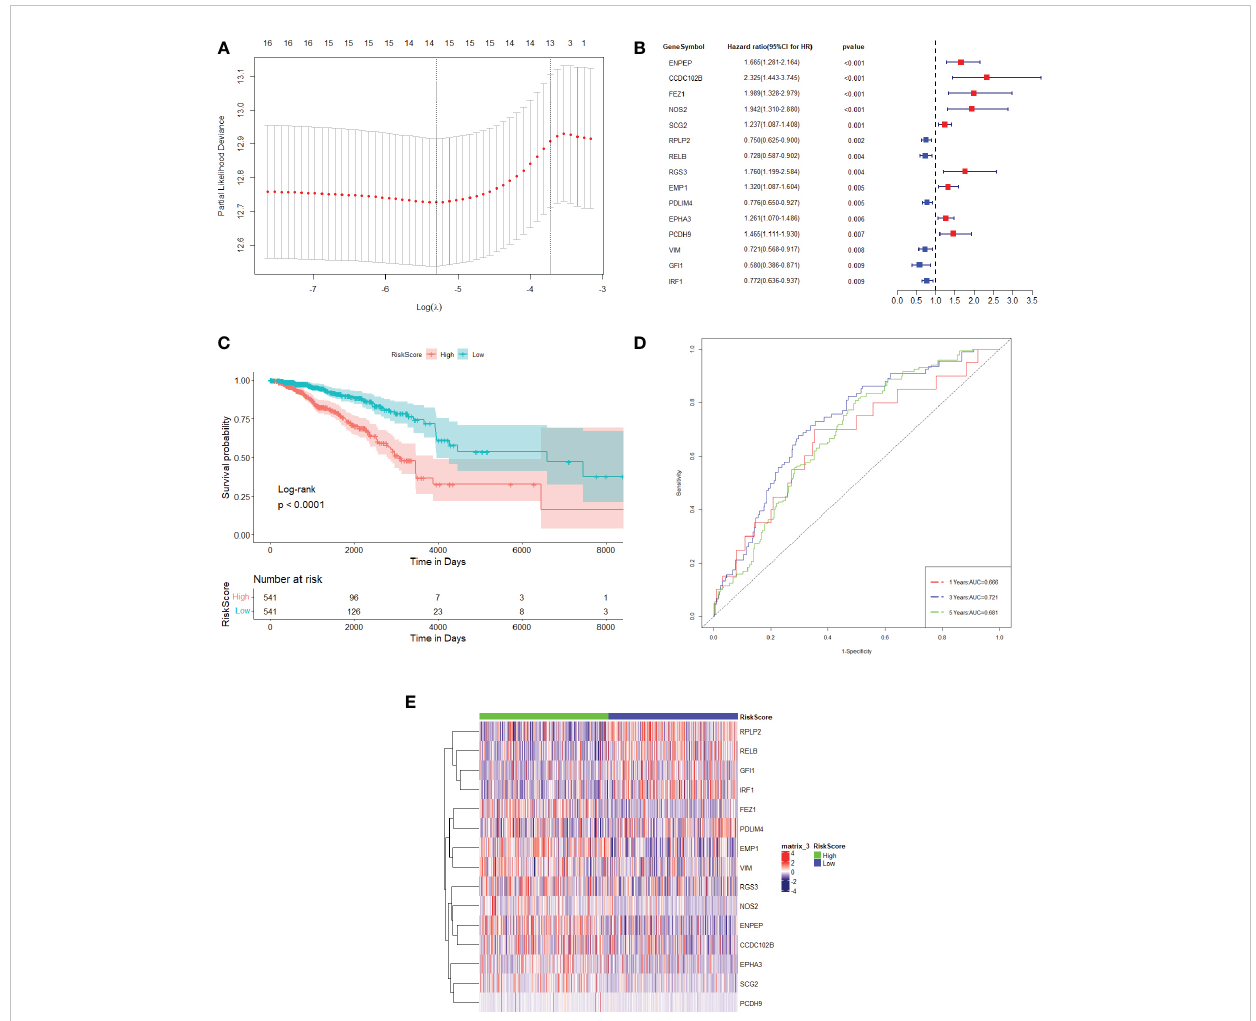
FIGURE 1 TME prognostic gene selections for breast cancer prognosis. (A) The plot of the determination of the tuning parameter lambda in the LASSO regression model. The horizontal axis is the log (lambda) and the vertical axis is the partial likelihood deviation value. The lambda value corresponding to the smallest value is the best. (B) Forest plot of the 15 most signi fi cant TME prognostic genes associated with breast cancer prognosis. HR is the hazard ratio and 95% CI is the 95% con fi dence interval. (C) Kaplan – Meier survival curve in the TCGA dataset. The horizontal axis represents time, while the vertical axis represents survival. Different colours represent different groups. The p -value is based on the log-rank test. (D) The time-dependent ROC curve. The horizontal axis is the false-positive rate, while the vertical axis is the true-positive rate. The accuracy of prediction is assessed by the AUC (area under the ROC curve) value. (E) The expression heat map of the 15 TME prognostic genes selected from the TCGA